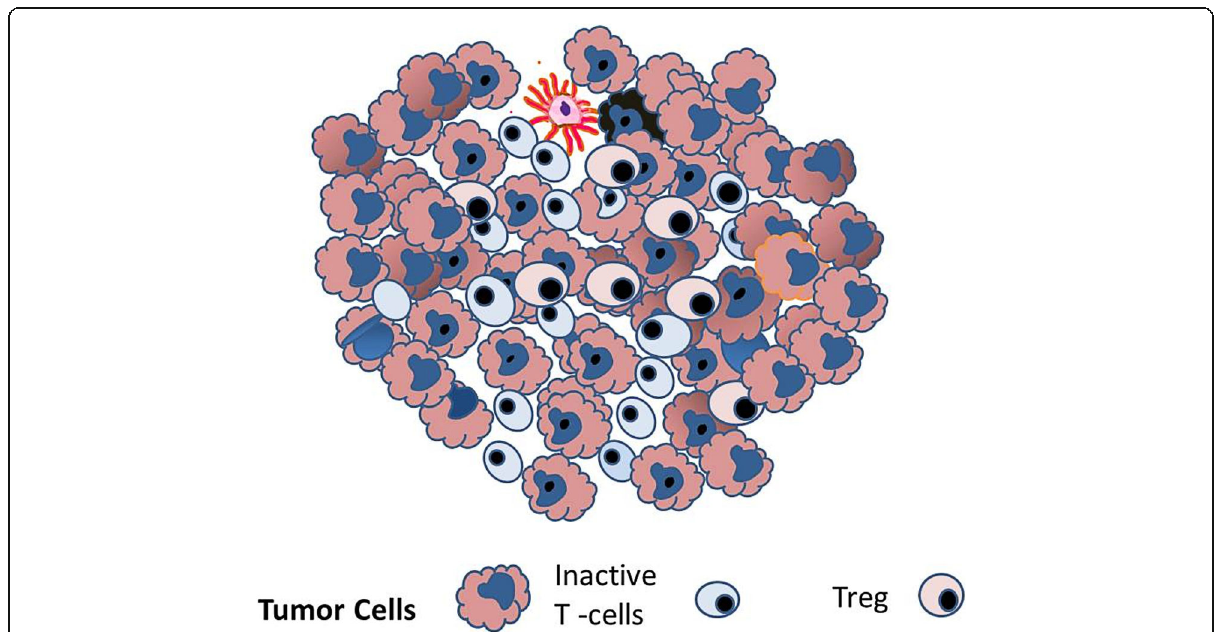
Fig. 8 As a consequence of the immune inhibitory environment, cancer cells can bypass the immune system, proliferate and undergo progression. Inactivated T-cells persist and are kept in an inactive state by